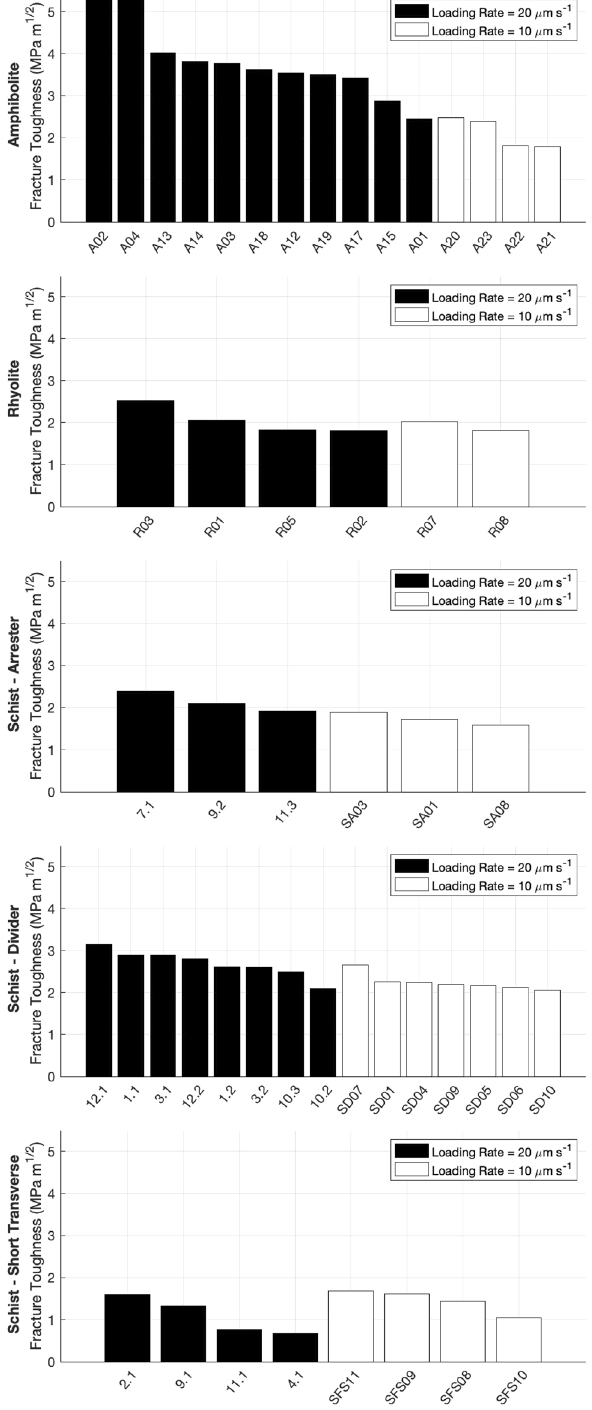
Figure 5. Fracture toughness values from all tests. Black bars indicate a loading rate of 20 μm/s, white bars indicate a loading rate of 10